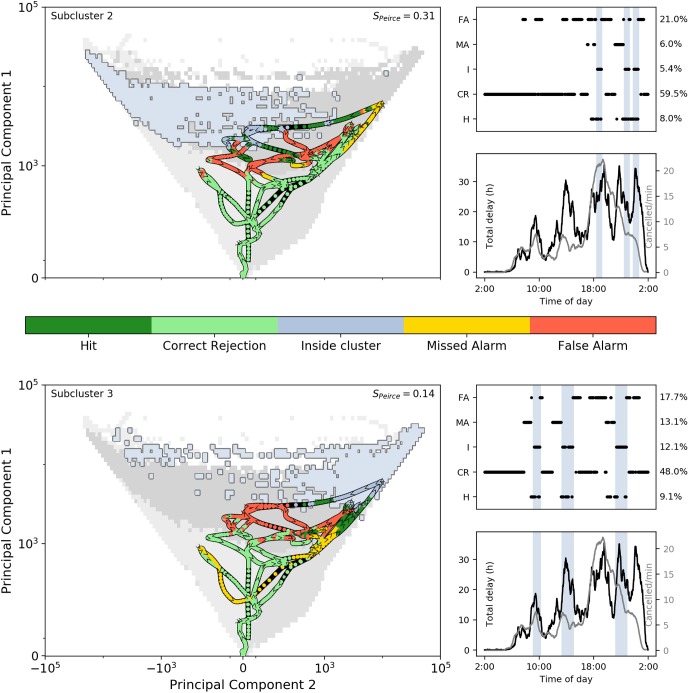
Same as in Fig 7, but for the case of April 19th 2018.